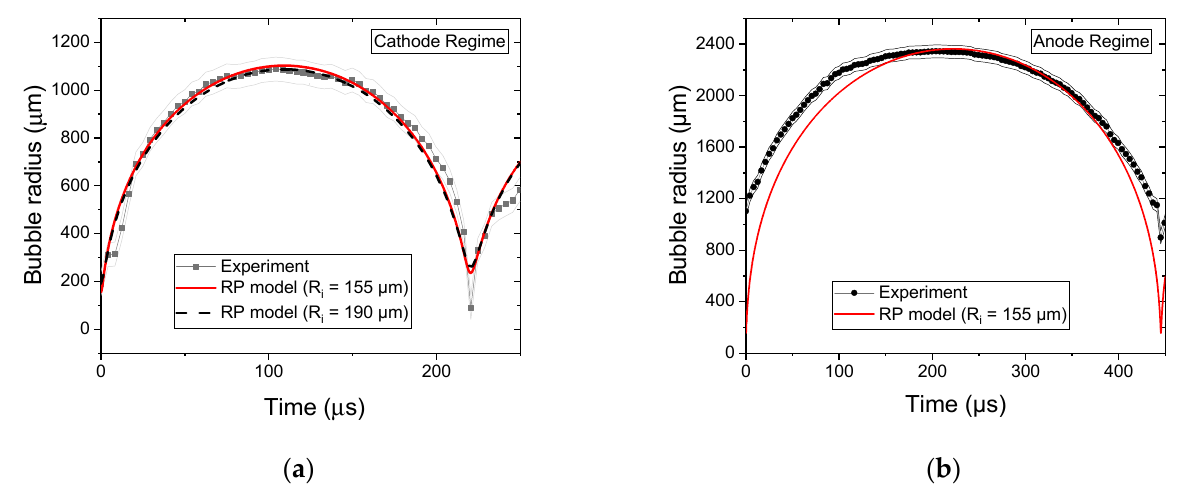
Figure 7. Time evolution of bubble radius. Comparison between experiment and modified Rayleigh– Plesset modeling for ( a ) cathode regime and ( b ) anode regime (grey areas stand for the experimental uncertainty). t = 0 µ s corresponds to the